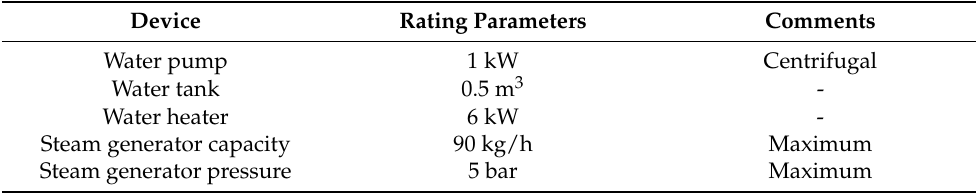
Table 4. The test rig equipment in the study of Zare et al. [40].